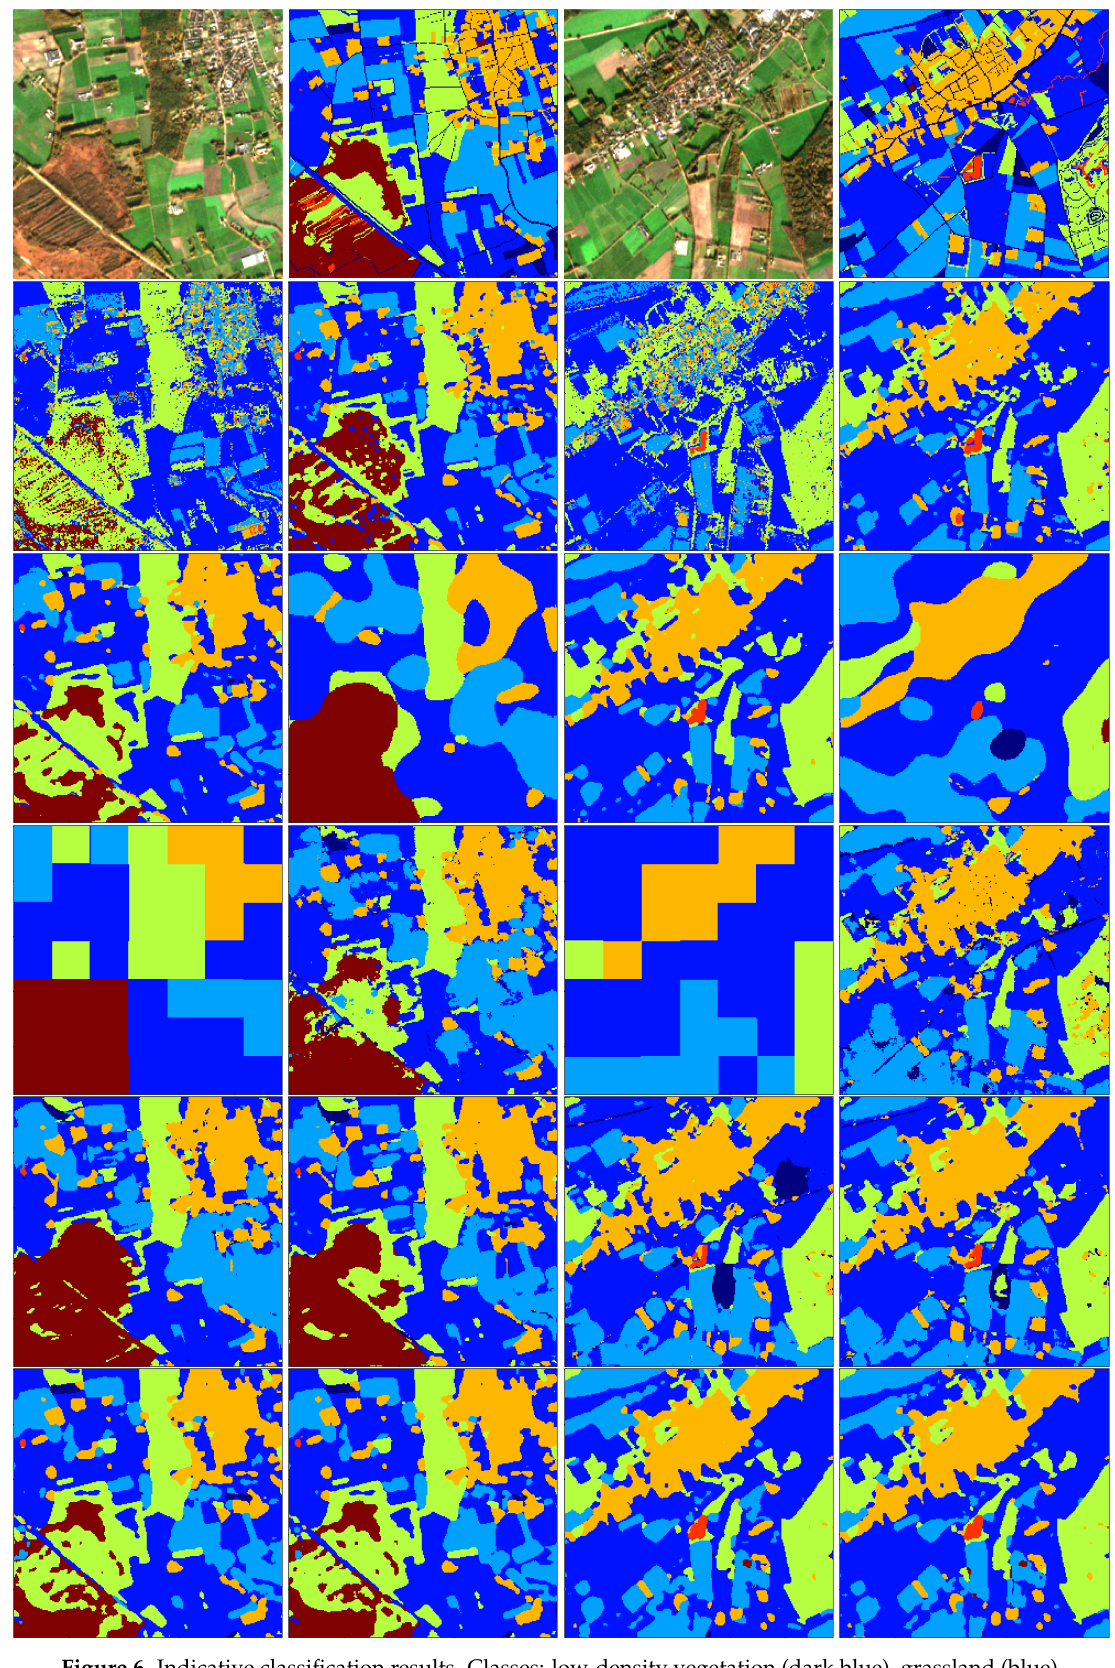
Figure 6. Indicative classification results. Classes: low-density vegetation (dark blue), grassland (blue), cropland (light blue), built-up (blue-green), forest (green), other (orange), water (red), and remaining classes